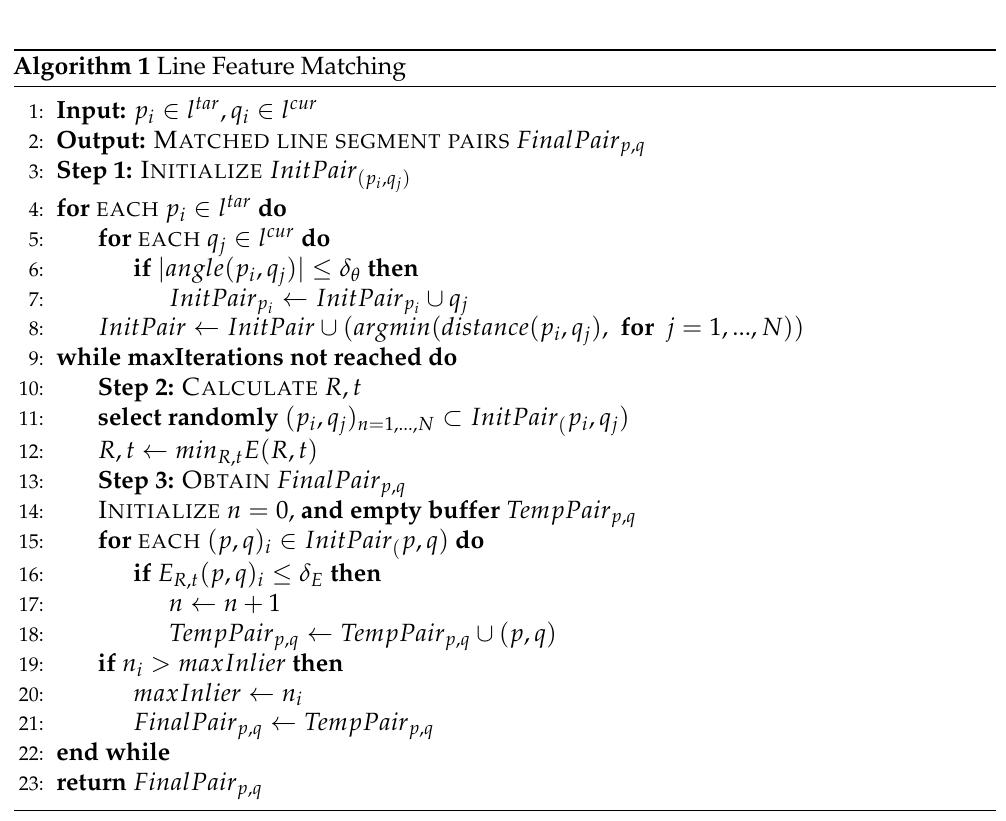
Figure 10. The final result of the paired line segments. The green lines indicate the paired line segments between the target image ( left ) and the current image ( right ).